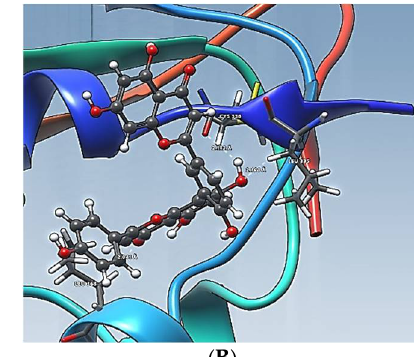
Figure 3. Representation of the surface charge distribution localization for: ( a ) Amentoflavone; ( b ) Chrysin; ( c ) Glycyrrhizin; ( d ) Myricetin_3′-Rhamnoside; ( e ) Myricetin_3-(4″-Galloylrhamnoside) with line representation and RBD with surface representation using atom charge scale (red-blue color palette changes from negative (blue) through neutral (white) to positive (red).